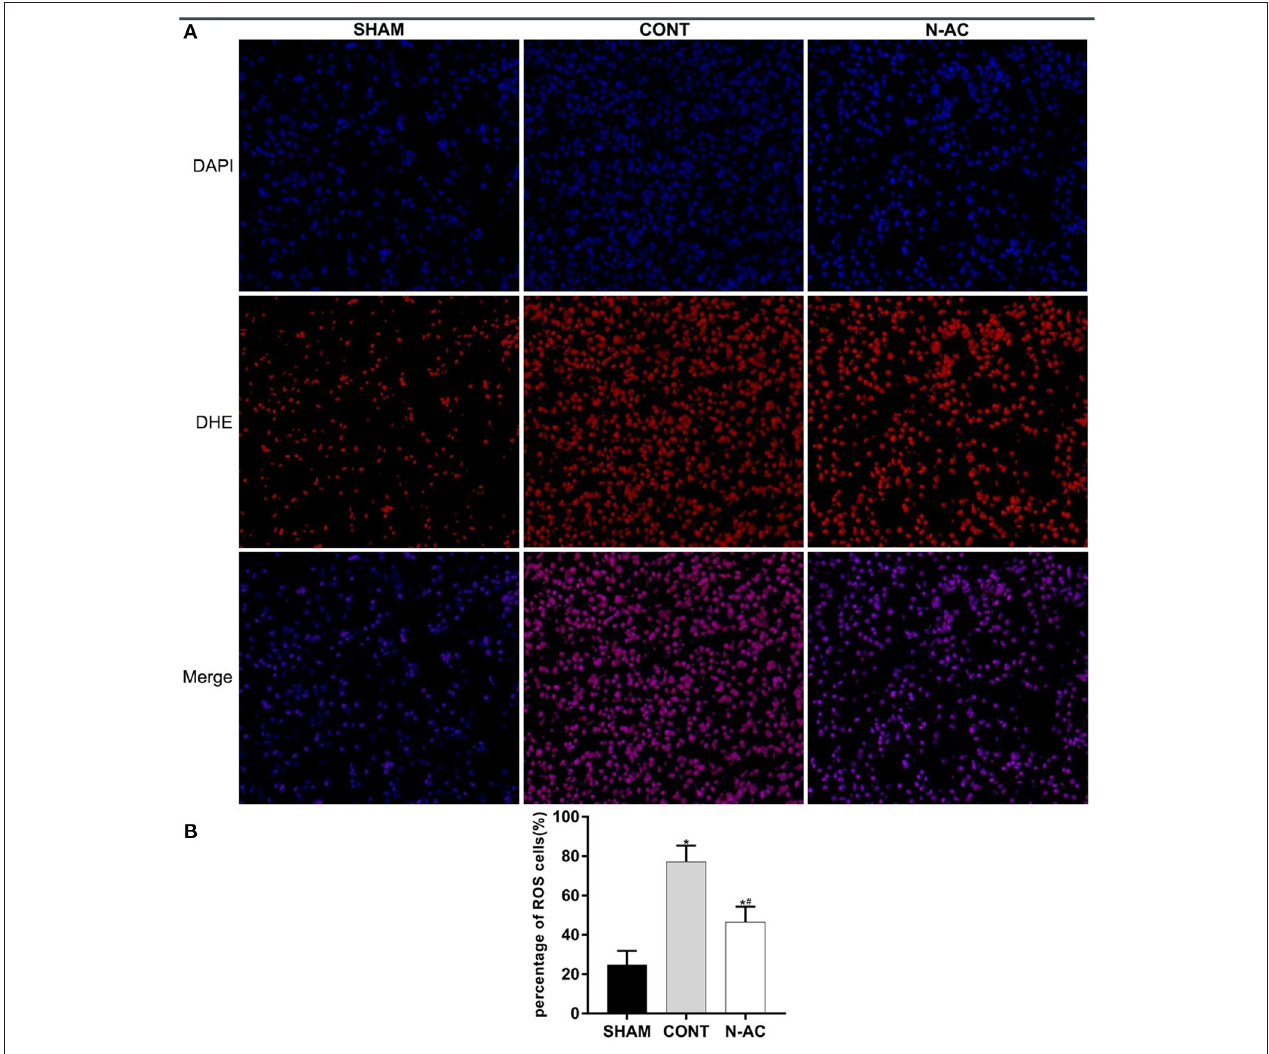
FIGURE 3 | N-AC reduced the generation of ROS in the kidney at 6h after ROSC. (A) Representative DHE staining showing the ROS levels in the kidney at 6h after ROSC. Scale bars = 10 µ m. (B) Percentage of ROS-positive cells defined as ROS-positive cells/DAPI-positive cells based on the DHE staining results. SHAM, sham group; CONT, control group; N-AC, N-AC group. Sham group, n = 5; Control group, n = 7; N-AC group, n = 7. Data are expressed as mean ± SD. * P < 0.01, vs. sham group; # P < 0.01, vs. control